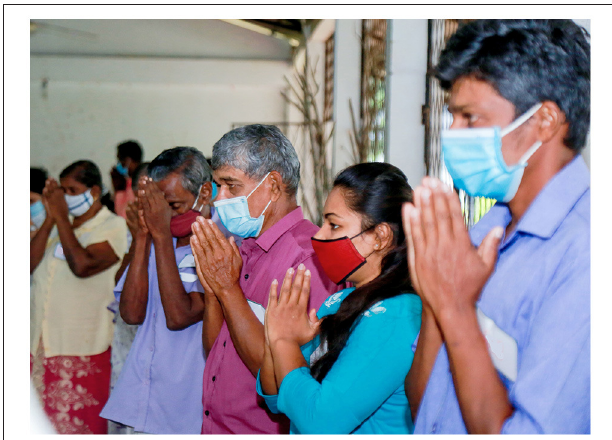
FIGURE 7 | Religious observance at the start of a CAG meeting in Sri Lanka.